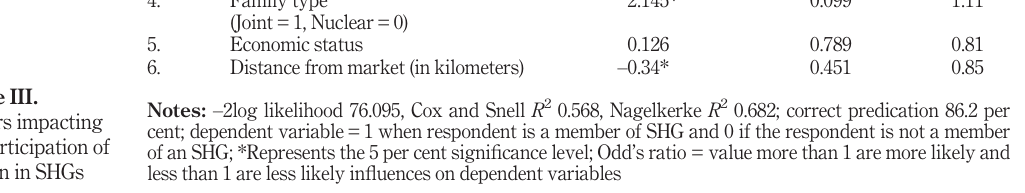
the participation of women in SHGs